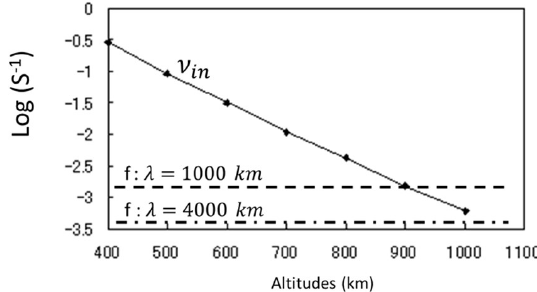
Figure 3. Ion-neutral collision frequency ( ν in ) in altitudes from 400 to 1000km calculated using the nighttime sunspot maximum con- dition in Prince Jr. and Bostick Jr. (1964). Wave frequencies of ion acoustic wave are overlaid for two wavelengths: 1000 and 4000km along field lines (see text).